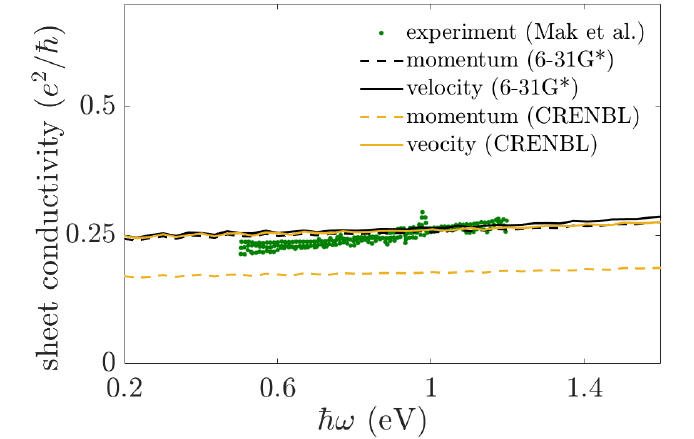
Figure 4: Same as Fig. 3 for the case of graphene. Experimentals results from Ref. [ 24 ] are shown. VME and MMe has been used to represent the velocity operator in the Kubo-Greenwood formula for the two DFT calculations (other approximations are not shown in this